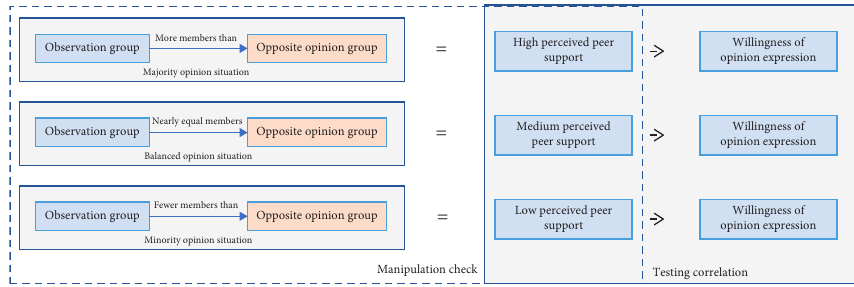
Figure 2: The workflow of study 1. Table 2: The significant test of manipulating the level of perceived peer support.